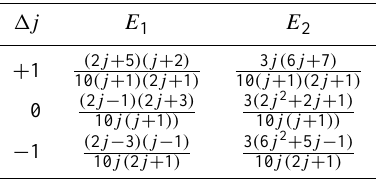
Table 1. E 1 and E 2 depend on the change of angular momentum 1j (from Chandrasekhar, 1960).